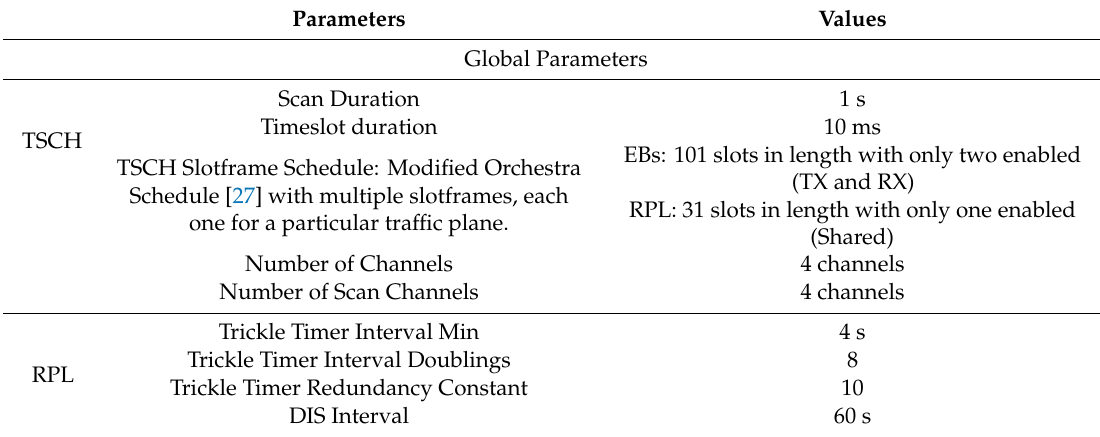
Table 4. Protocol stack